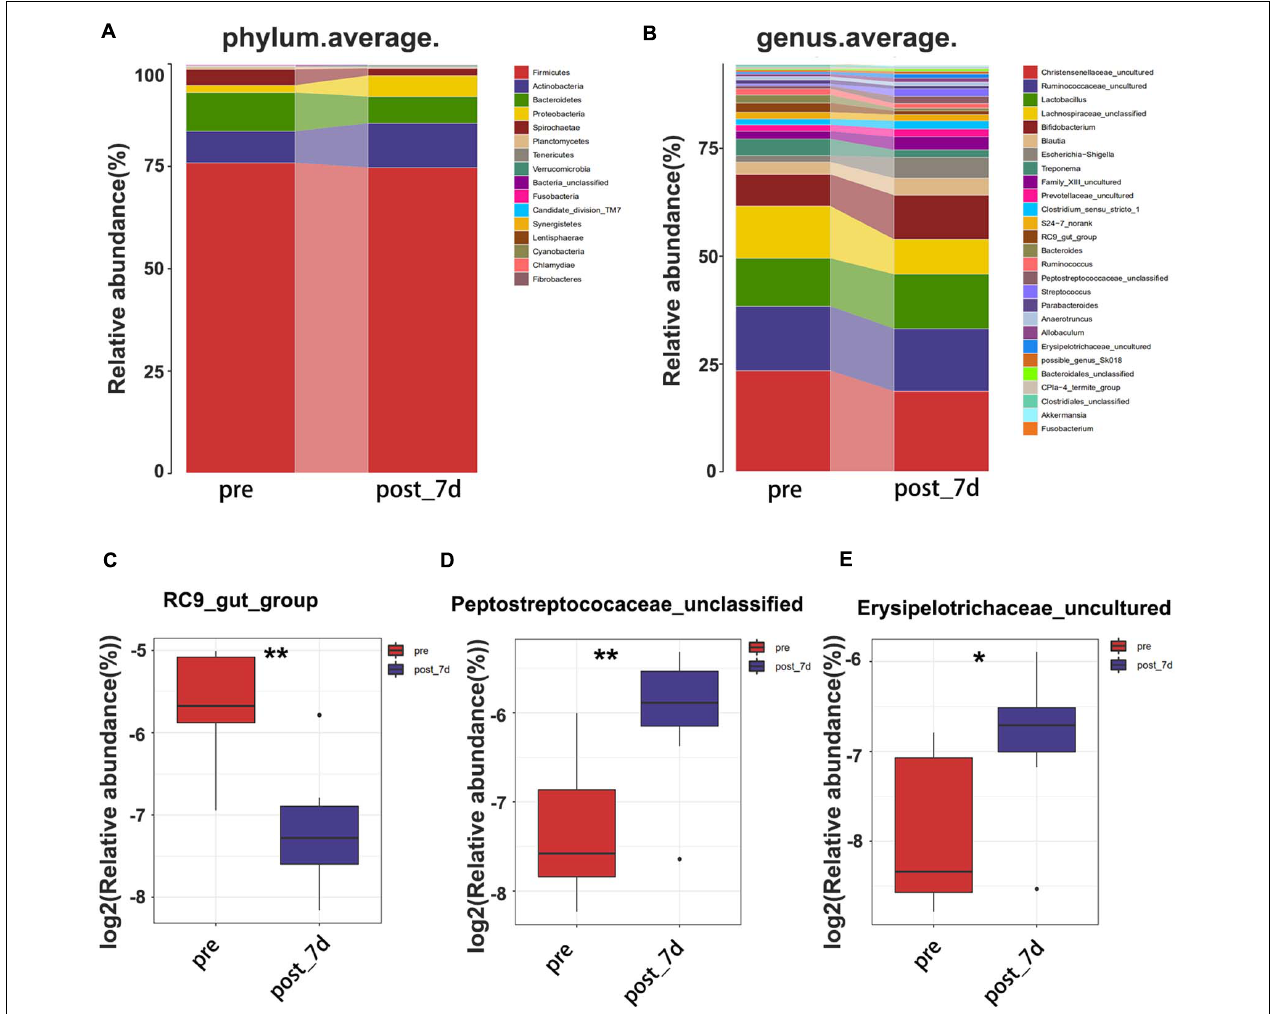
FIGURE 6 | Composition of faecal microbiota assigned to phylum level (A) and genus level (B) between the two groups. The decreased microbial community (C) at the genus level in the post_7d group with the pregroup. The increased microbial community (D,E) at the genus level in the post_7d group with the pre-group. The post_7d group, the 7-day group; the pre-group, and the control